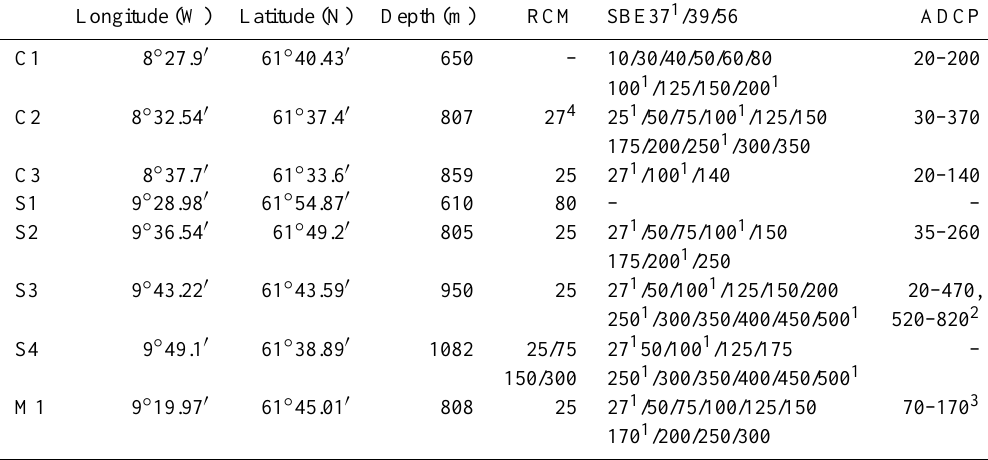
Table 1. Details of the moorings deployed from 28 May 2012 to 5 June 2013 downstream of the FBC sill. For instrumentation, the tar- get height above bottom (in metres above bottom, mab) is given. RCM is the Aanderaa Recording Current Meter, SBE is Seabird, and ADCP is the acoustic Doppler current profiler. The interval given in the ADCP column shows the depth range (in mab) for which velocity measurements are